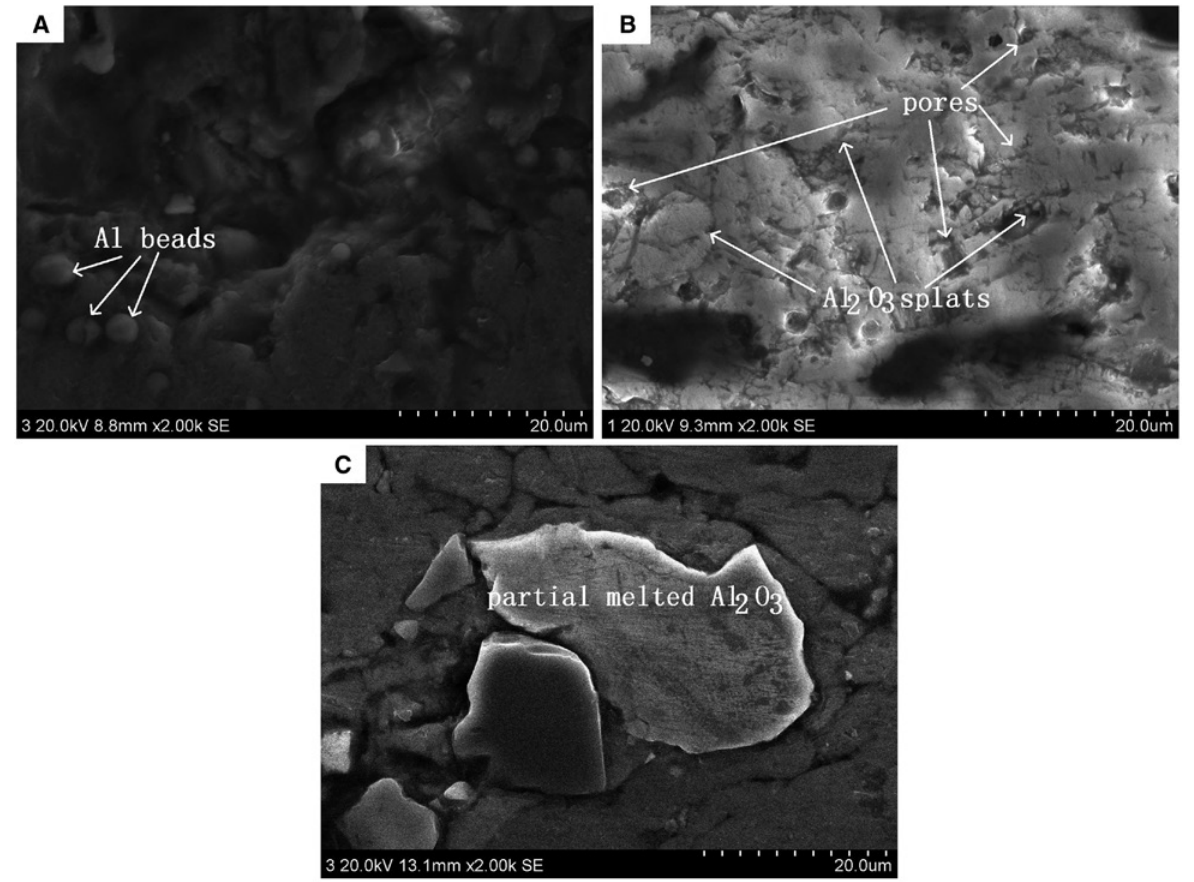
O -Al composite 2 3